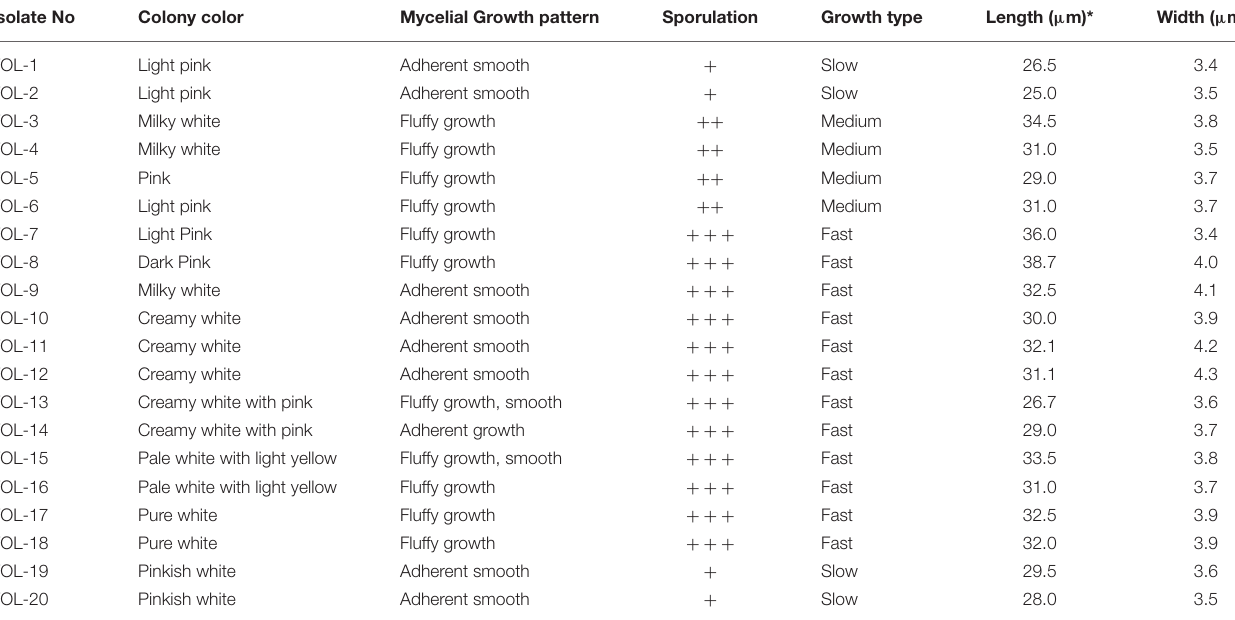
TABLE 2 | Cultural and morphological characters of different isolates of Fusarium oxysporum f.sp. lycopersici . Isolate No Colony color Mycelial Growth pattern Sporulation Growth type